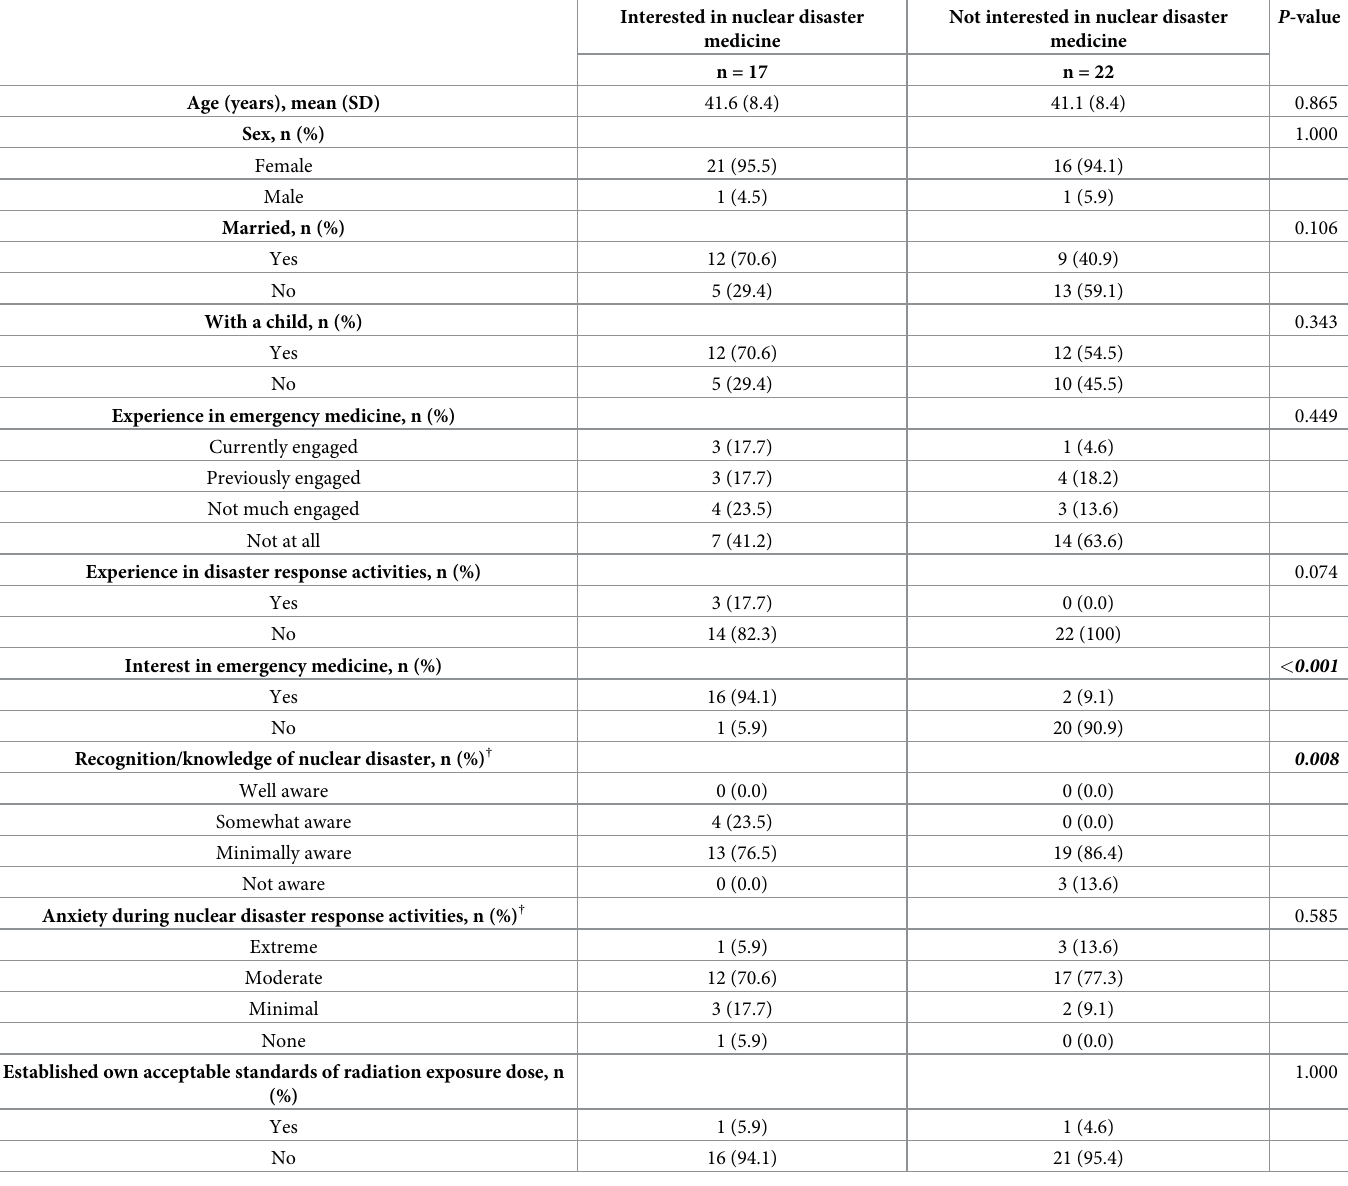
Table 1. Characteristics of